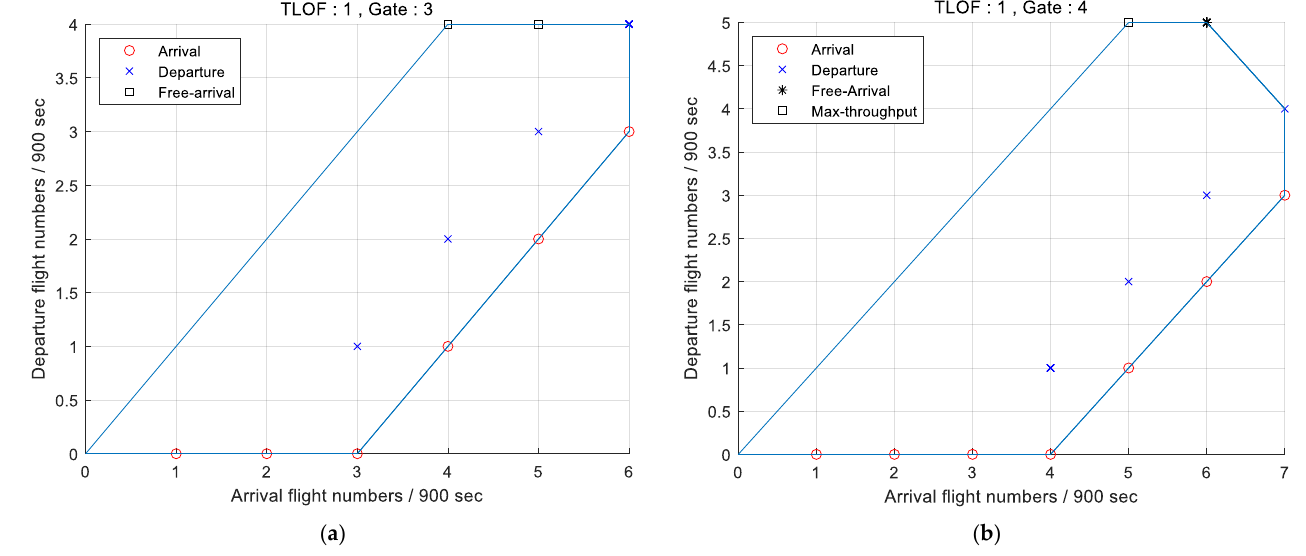
Figure 28. The satellite topology capacity of the current Gimpo Airport parking lot that complies with the FAA’s new regulations : ( a ) 1 TLOF, 3 Gates; ( b ) 1 TLOF, 4 Gates.